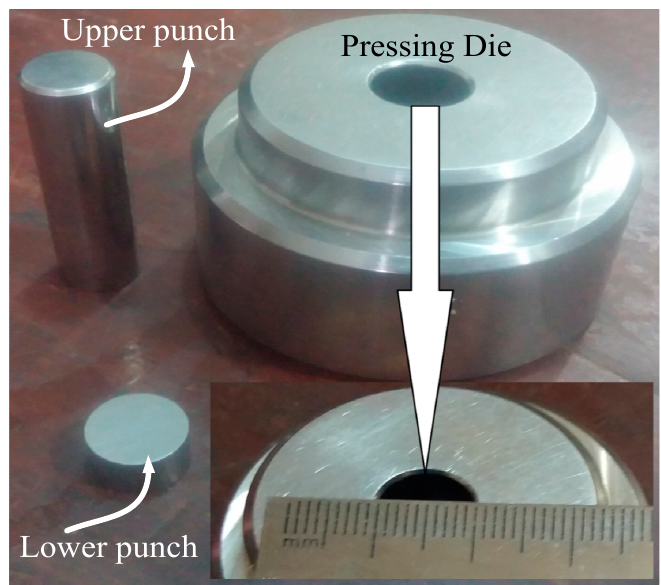
Figure 1. Pressing die with lower and upper punches.